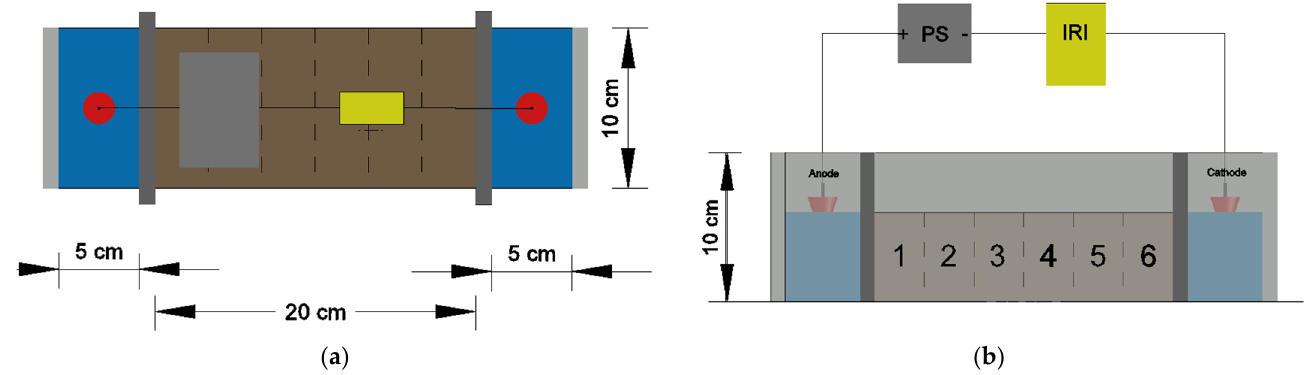
Figure 1. EKR cell disposal. PS: power source. IRI: multimeter with data acquisition. ( a ) upper view; ( b ) front view. Numbers 1 through 6 are partitions used for measuring concentration results.